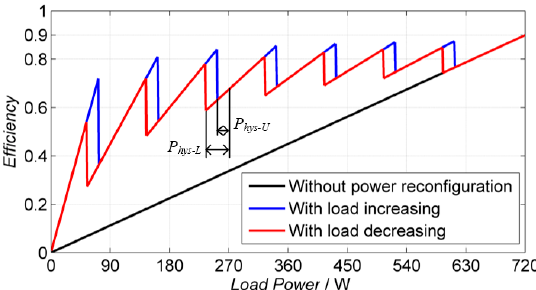
Figure 6. With the hysteresis mechanism applied, the conversion efficiency with respect to the external load power calculated through Equation (2). Assuming ξ = 0.9.